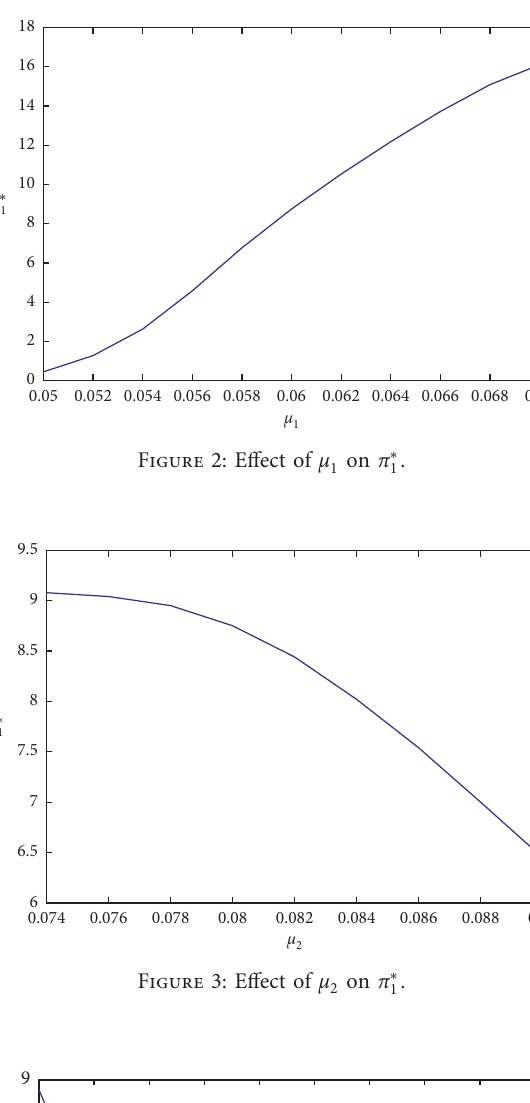
Figure 3: Effect of μ